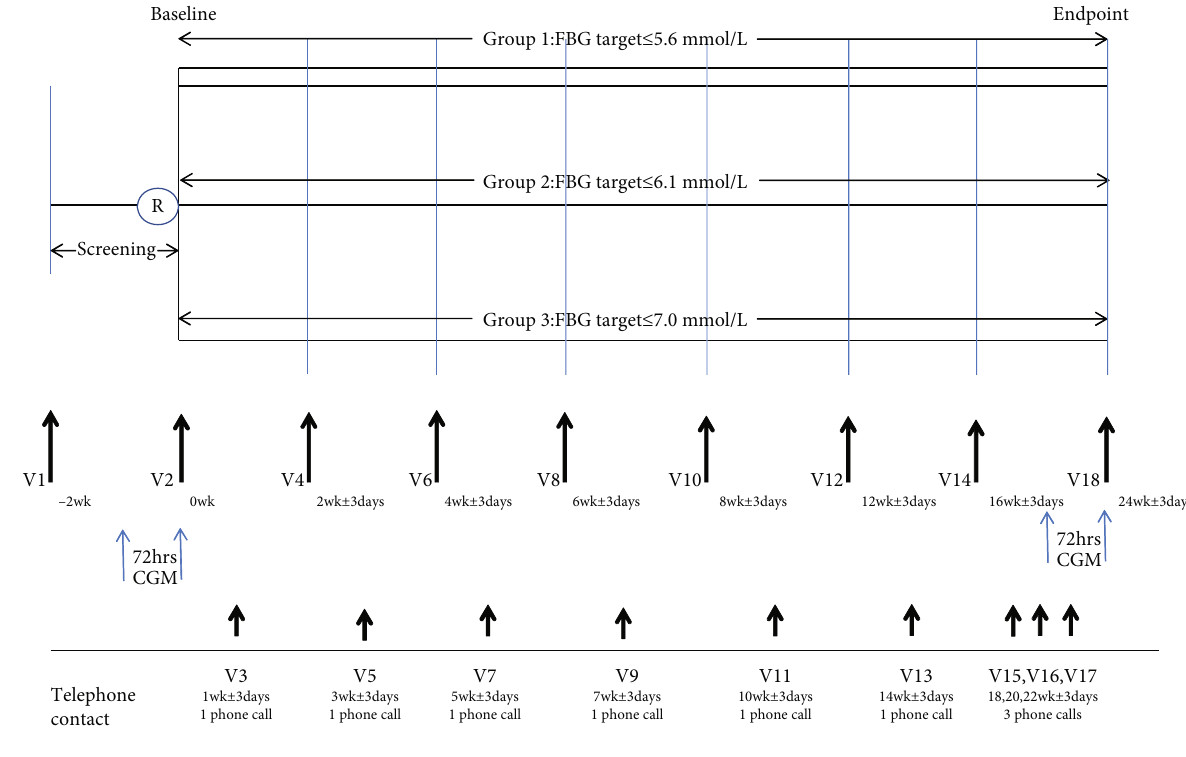
Figure 1: Study fl ow chart. Table 1: Titration regimes for recruited